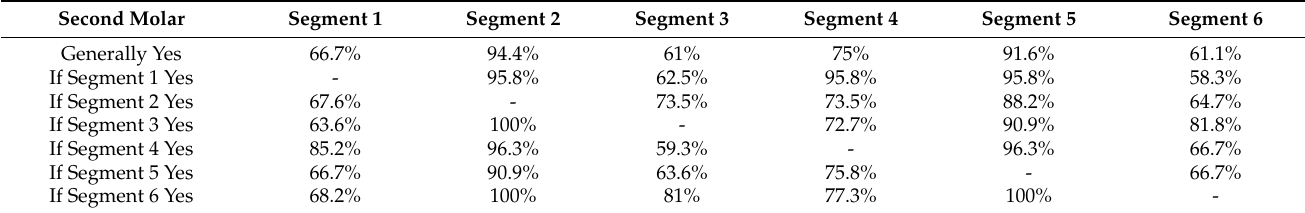
Table 3. Percentage of the IAN’s intraosseous position at the level of the second molar. In the presence of a hyperintense signal in a specific segment, it is noted whether other segments were simultaneously filled.